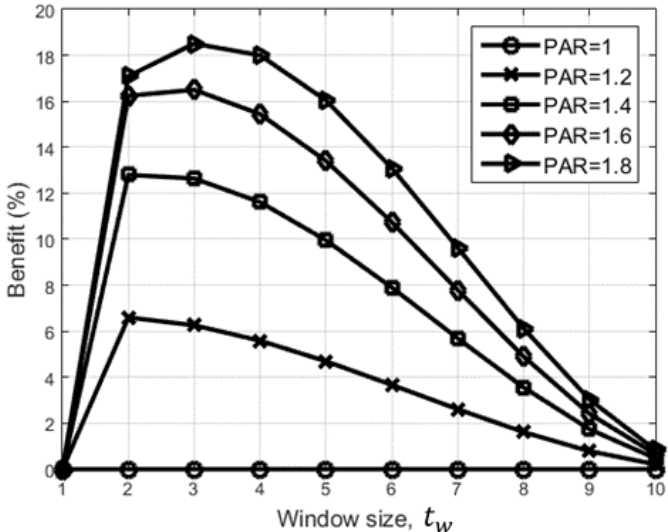
Figure 8. Benefits versus window sizes with varying PAR.